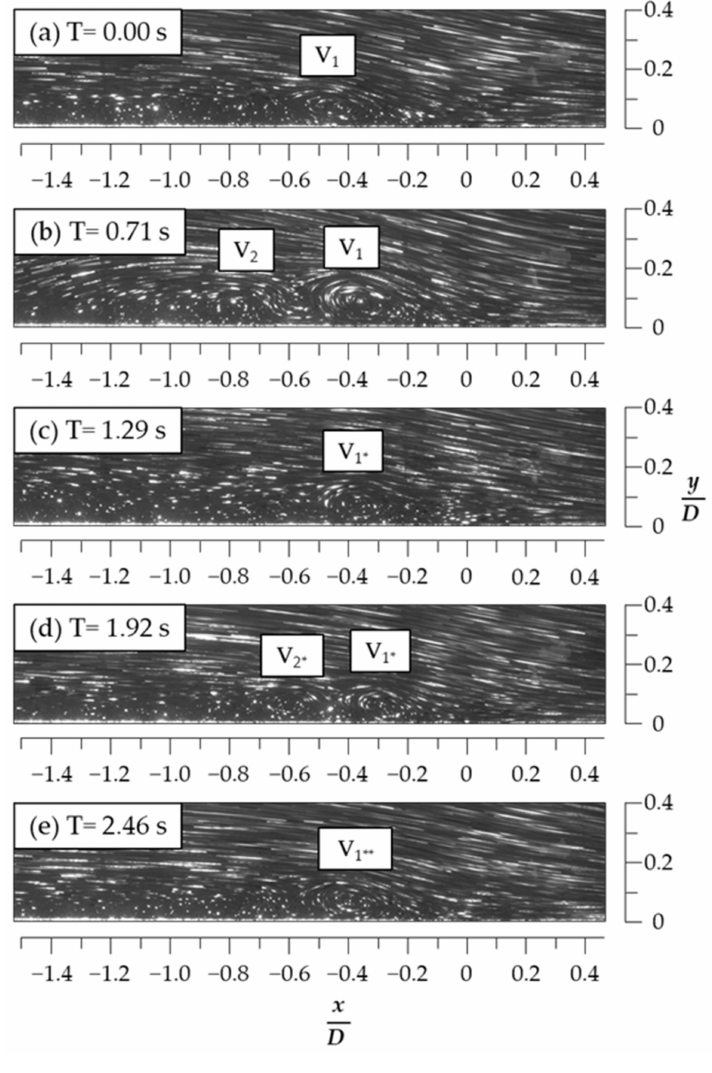
Figure 16. Time-series flow visualization of the HSV’s kinematic mode: “mixed” in the z = 0.8 cm plane when H / D = 1.5. ( a ) The core of the primary vortex V 1 was initially located at ( x / D , y / D ) = ( − 0.42, 0.07); ( b ) a new roll-up vortex V 2 formed due to flow disturbances; from ( b ) to ( c ), V 1 and V 2 were merging with each other to form a new primary vortex V 1* ; from ( d ) to ( e ), a similar process to that from ( b ) to ( c ), a roll-up vortex V 2* was formed, and then V 1* was merging with V 2* to form a new primary vortex V 1** with its core located at ( x / D , y / D ) = ( − 0.37,